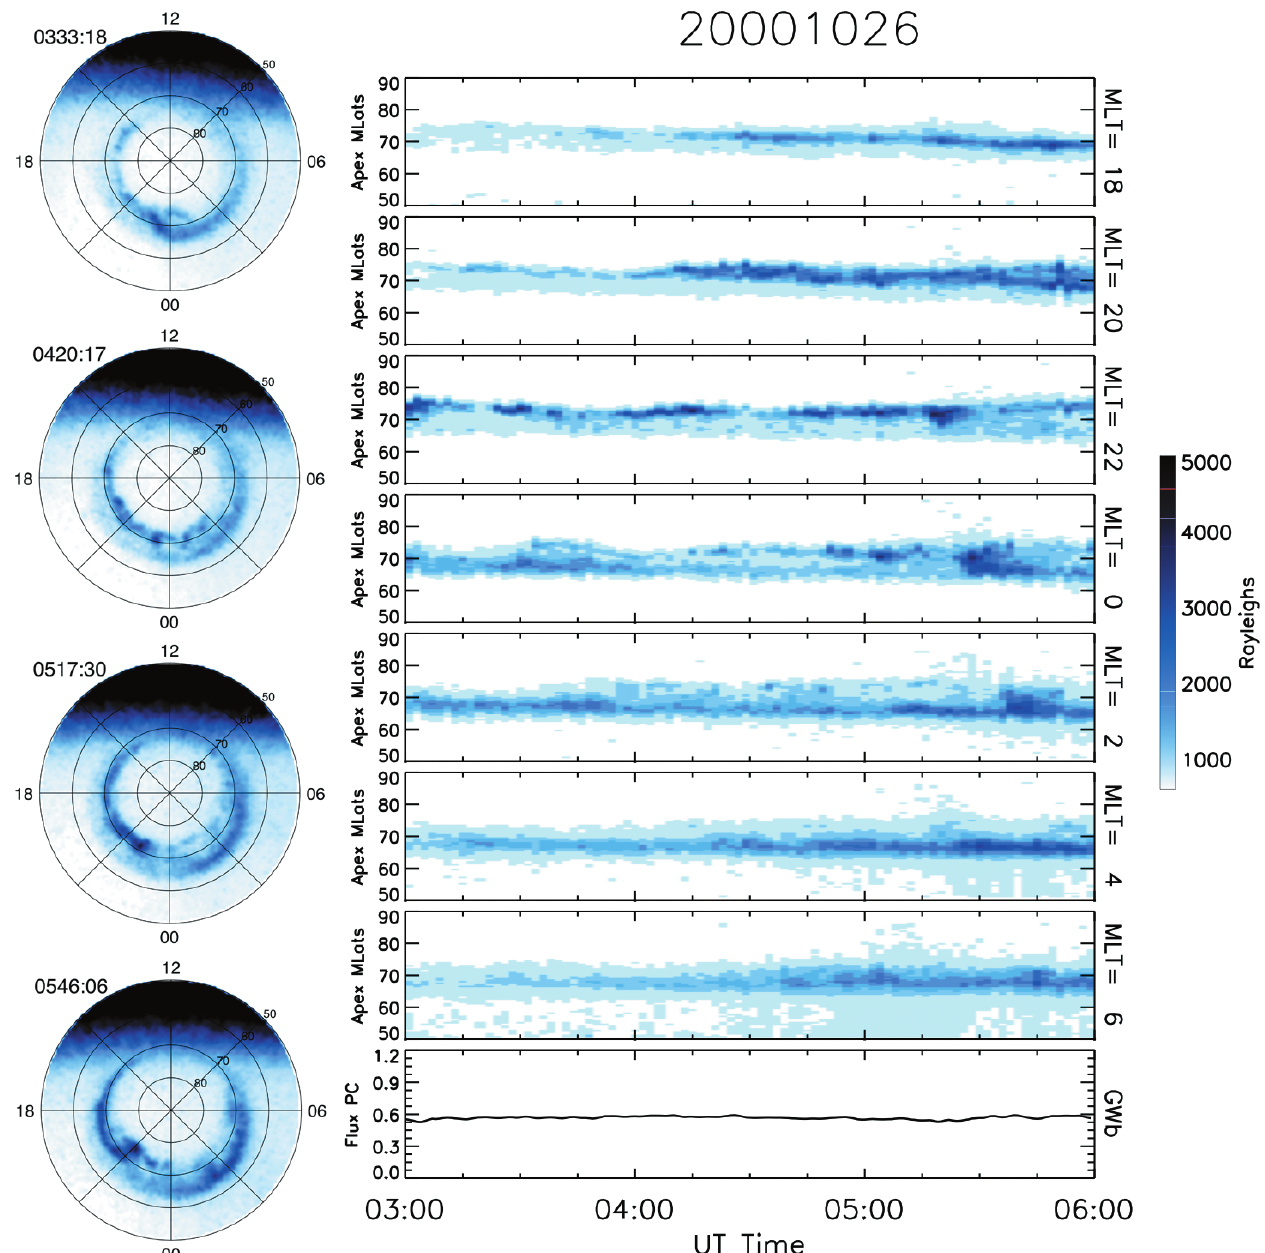
Fig. 8. A stack plot of keograms for the SMC on 26 October 2000. Set up is the same as Fig. 3.